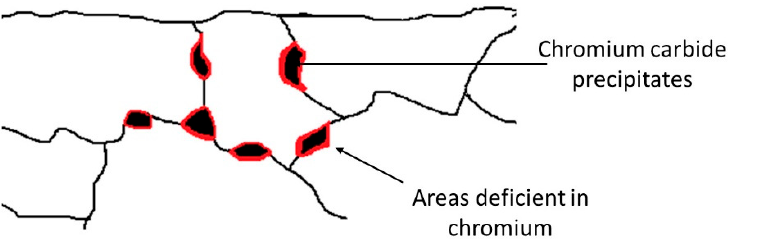
Figure 1. Schematic representation of the precipitation of different phases, such as chromium carbides and mixed carbides at the grain boundaries in stainless steel during sensitisation.